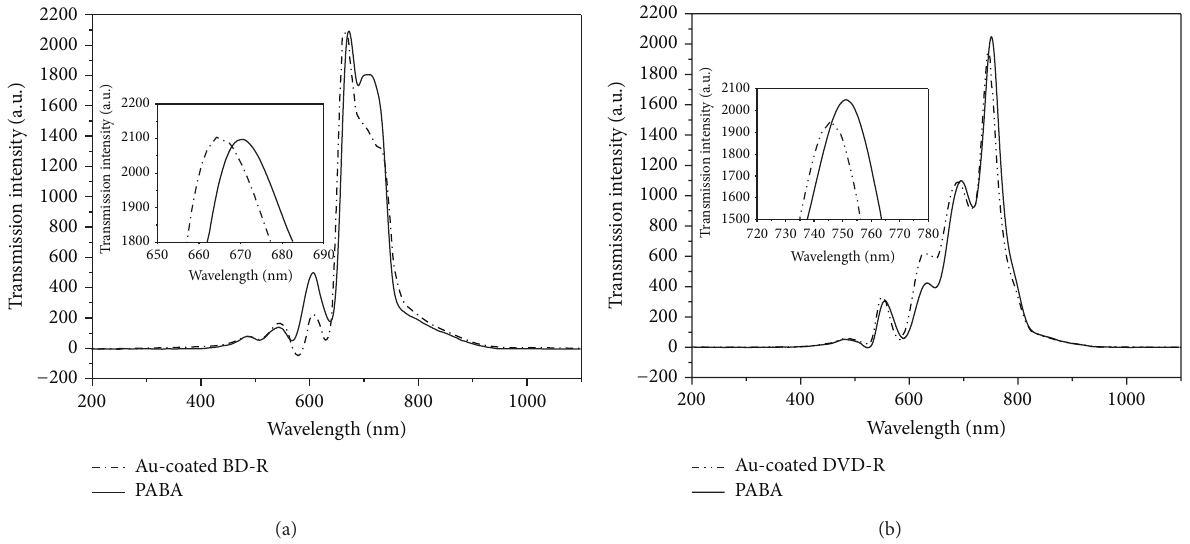
Figure 3: T-SPR spectra taken in water before and after electropolymerization of 3-ABA on (a) BD-R and (b) DVD-R grating substrates.